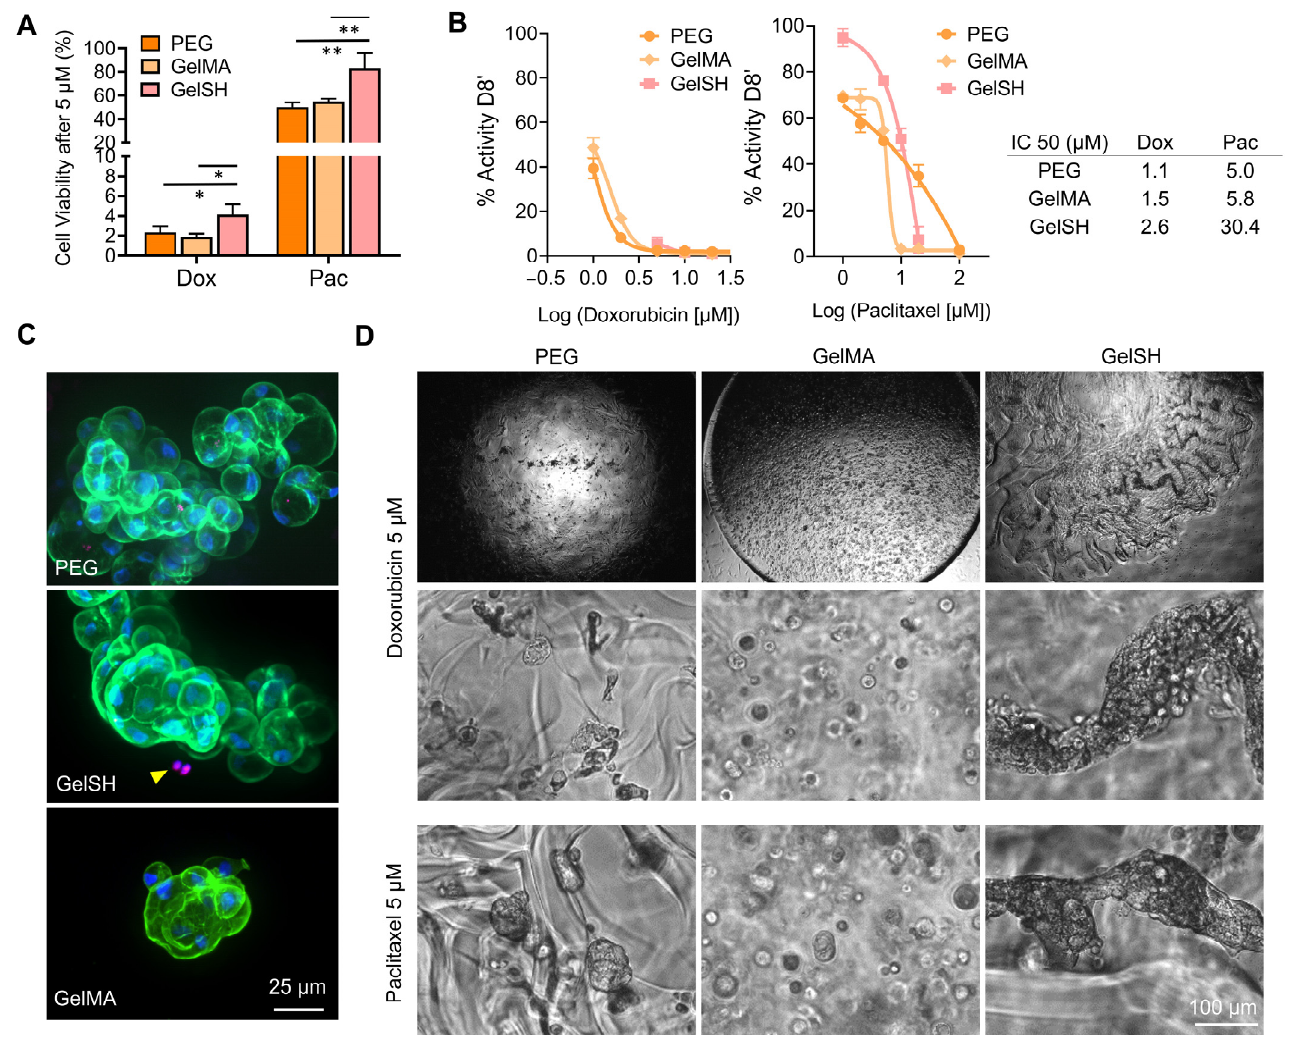
Figure 8. Doxorubicin and paclitaxel response on 3D PDO cultures in PEG, GelSH and GelMA biomaterials of similar stiffness (3 kPa) from P#04F patient-derived cells after 8 days of treatments (administered twice at day 0 and day 4). (* p < 0.01, ** p < 0.05). ( A ) Cell viability after 5 µM of doxorubicin (Dox) and paclitaxel (Pac). ( B ) IC 50 doses responses. ( C ) Confocal images of immunofluorescence for DAPI (blue), γ H2AX (magenta), Phalloidin (green) staining prior to drug testing showing undamaged organoids, yellow arrows show organoids damage. ( D ) Brightfield images of 3D PDO morphology in PEG, GelSH and GelMA gels 5 µM of doxorubicin (Dox) and paclitaxel (Pac).